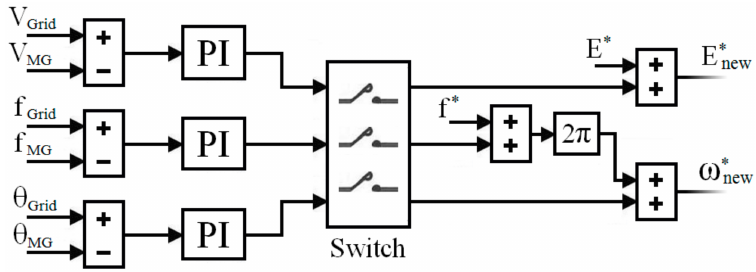
Figure 8. Pre-synchronization scheme of droop control.